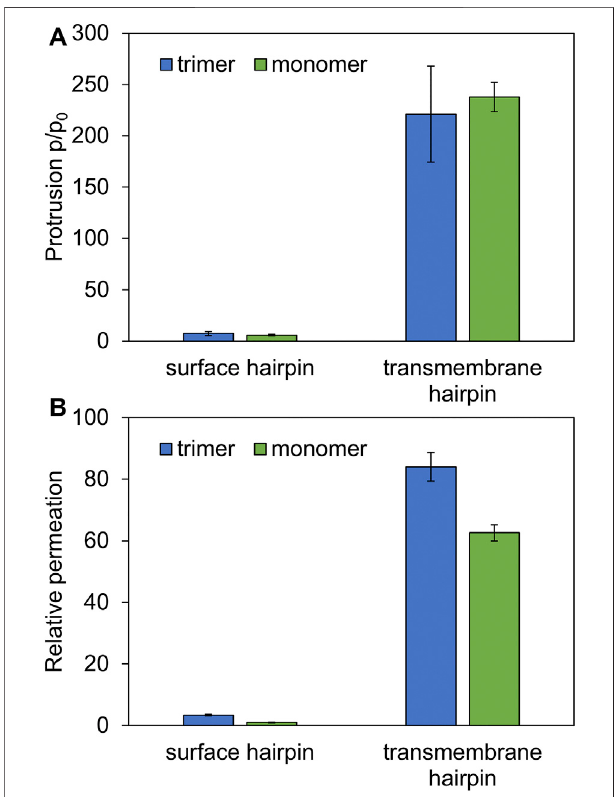
FIGURE 7 | (A) Ratios of lipid tail protrusions for lipids within 0.7 nm distance from HAfp atoms to lipids in pure POPC membrane. (B) POPC membrane-water permeation for 1:78 peptide to lipid ratio in the presence of HAfp, relative to pure membrane slab composed of 78